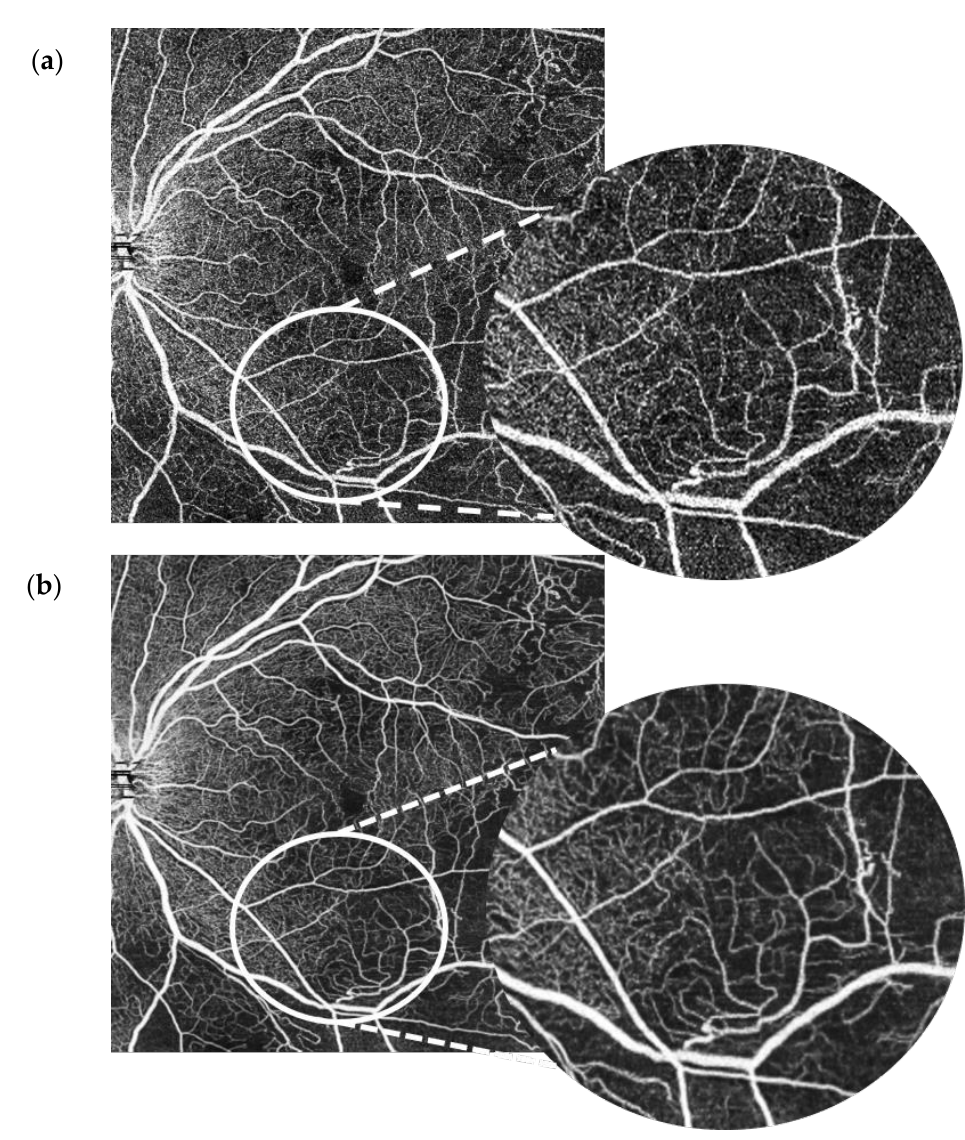
Figure 1. 10 × 10 mm OCT-A scan of the superficial capillary plexus in a patient with systemic lupus erythematosus retinopathy. Baseline image ( a ) vs. denoised image ( b ).